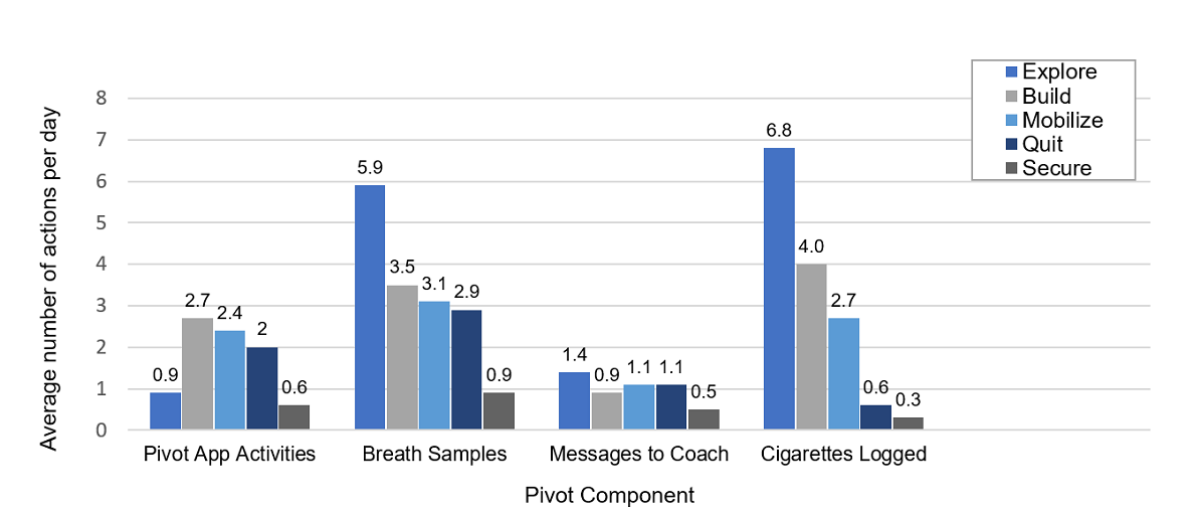
Table 5. Change in readiness to quit from baseline to the end of Explore.